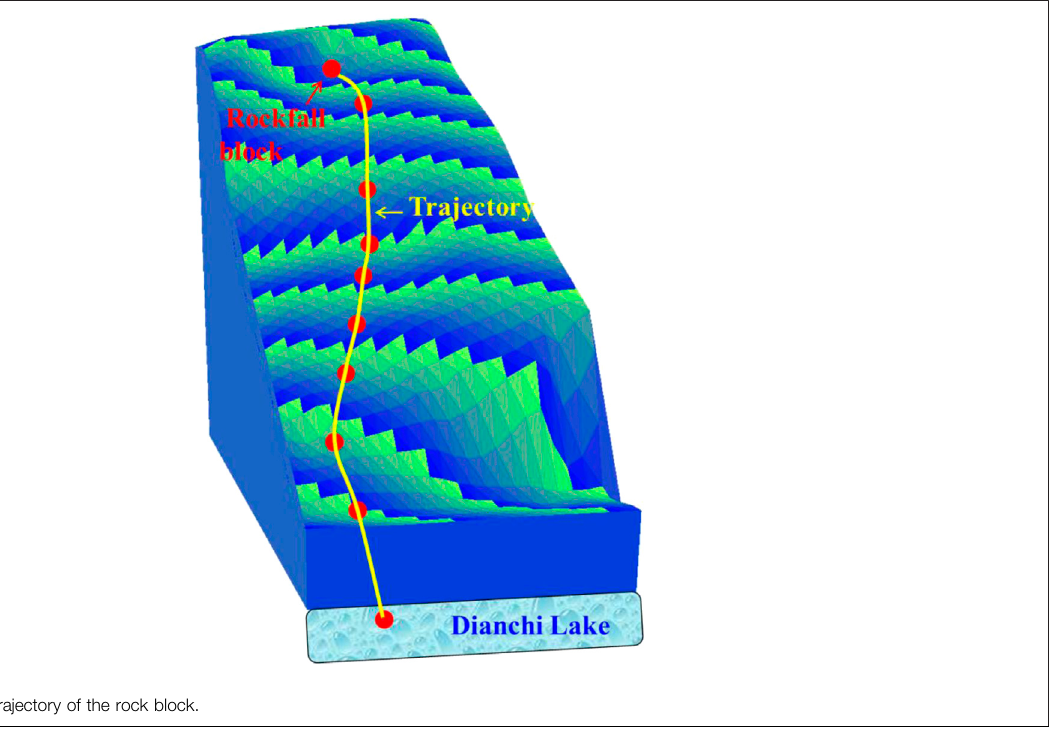
Frontiers in Earth Science |